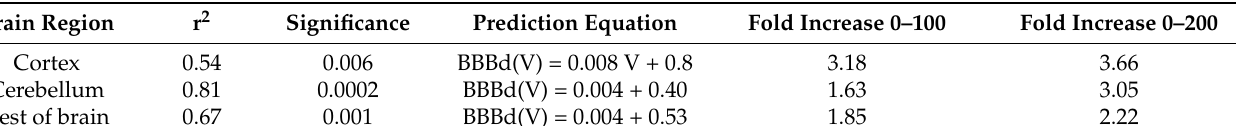
Table 2. Results of linear regression analysis for the three brain regions.